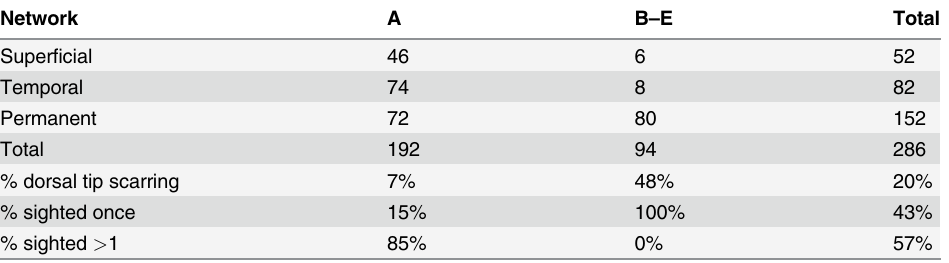
Table 2. Statistic descriptive of mark severity, dorsal tip damage and sighting record for network A and network B-E. Network Temporal